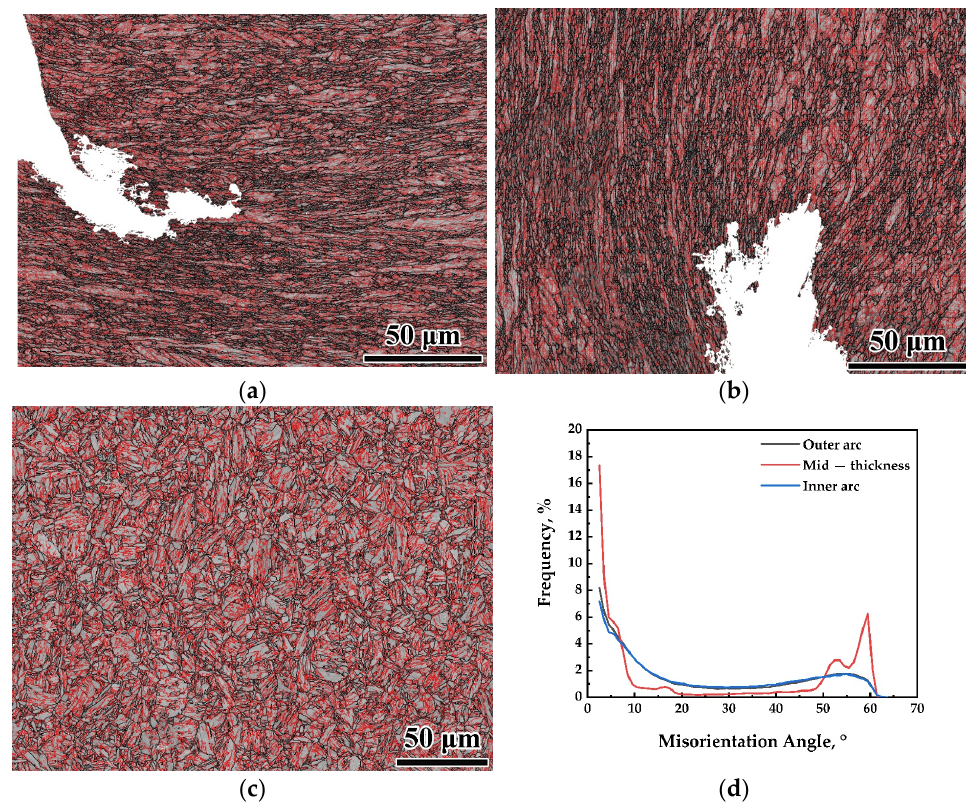
Figure 10. The grain boundary misorientation maps at the bending axis of the 5% Ni steel: ( a ) outer arc surface, ( b ) inner arc surface, ( c ) mid-thickness, and ( d ) distribution of grain boundary misorientation.